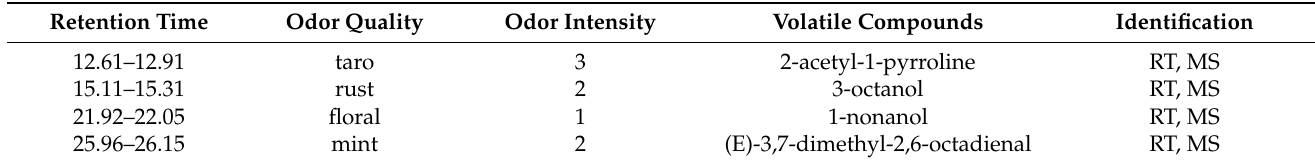
Table 3. The most potent odorants in pumpkin leaf (sample NO.312) with ‘taro-like’ aroma via